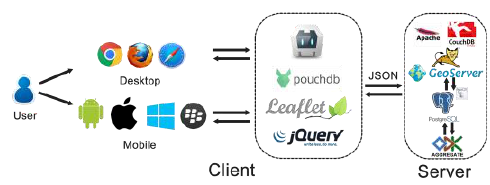
Figure 3. System architecture of the application